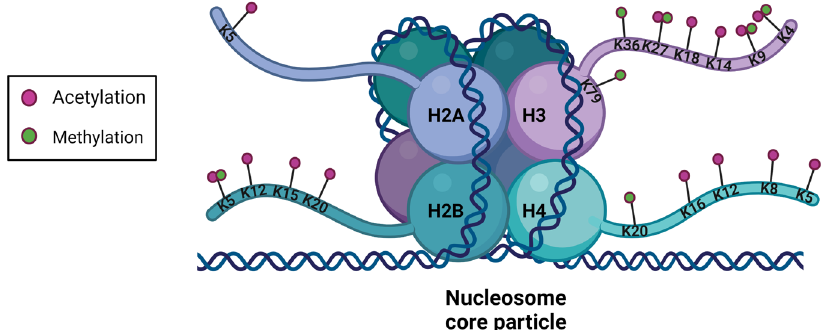
Figure 2. Structure of a nucleosome and main sites of methylation and acetylation in histones. Post-translational modifications of the histones are mostly performed on the amino-terminal tails of the histones accessible to the epigenetic writer and eraser. Acetylated residues are in pink and methylated ones are in green.